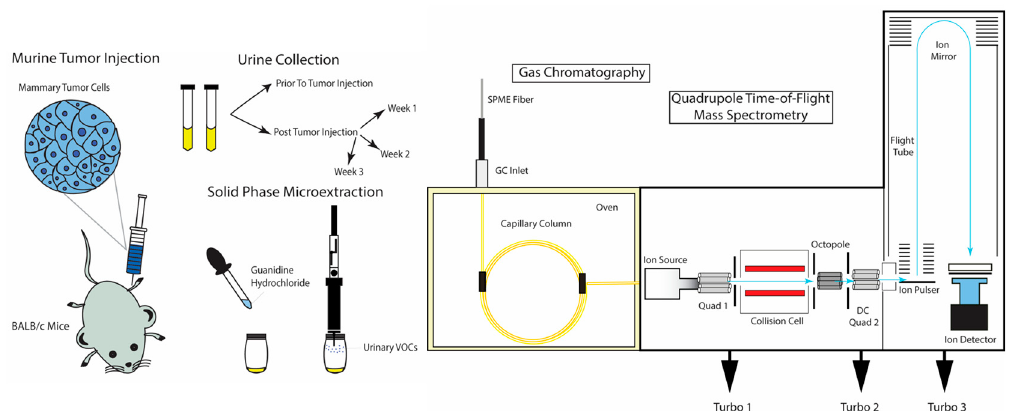
Figure 1. Illustration of murine tumor injection, mouse urine sample collection, sample treatment and analysis via solid phase microextraction coupled to gas chromatography-quadrupole time-of-flight mass spectrometry to identify volatile organic compound (VOC) biomarkers for breast cancer and tumor progression.